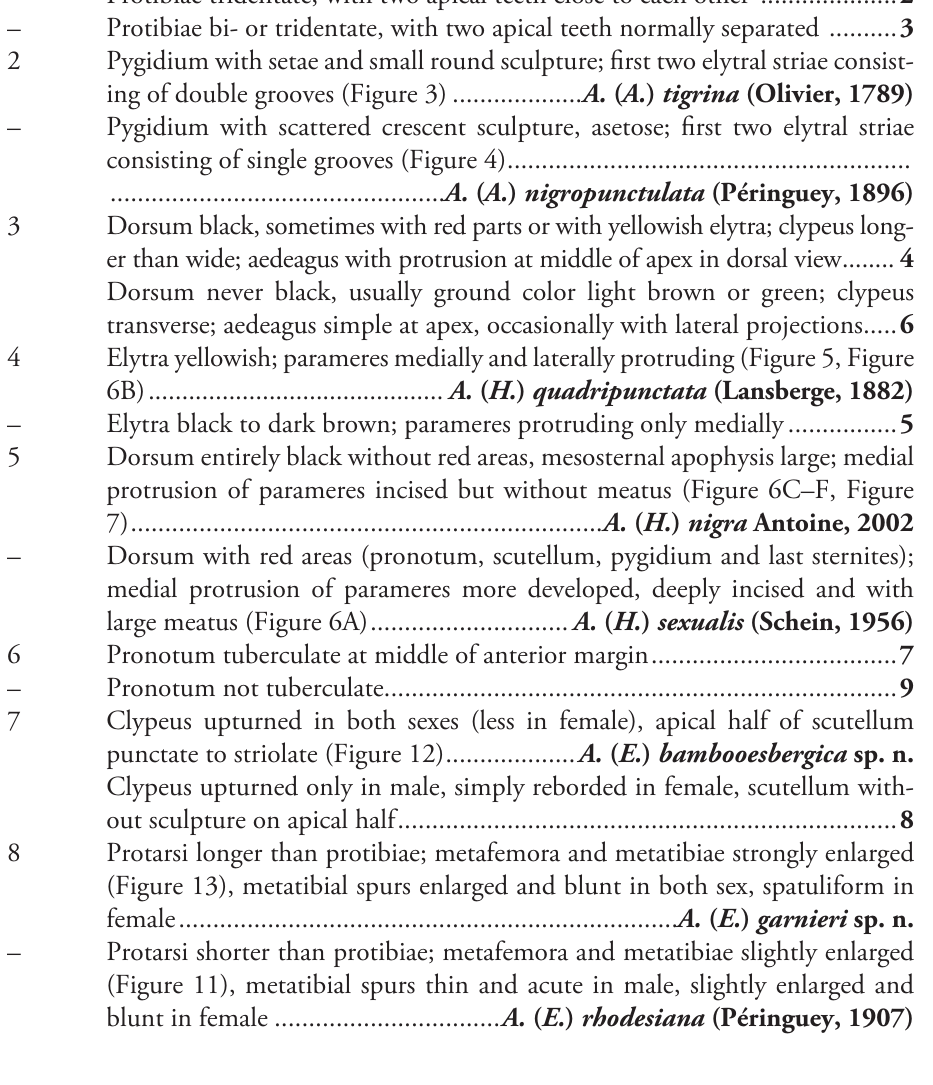
– Protibiae bi- or tridentate, with two apical teeth normally separated .......... 3 2 Pygidium with setae and small round sculpture; first two elytral striae consist- ing of double grooves (Figure 3) ................... A. ( A. ) tigrina (Olivier, 1789) – Pygidium with scattered crescent sculpture, asetose; first two elytral striae consisting of single grooves (Figure 4) ........................................................... ................................................. A. ( A. ) nigropunctulata (Péringuey, 1896) 3 Dorsum black, sometimes with red parts or with yellowish elytra; clypeus long- er than wide; aedeagus with protrusion at middle of apex in dorsal view ........ 4 Dorsum never black, usually ground color light brown or green; clypeus transverse; aedeagus simple at apex, occasionally with lateral projections..... 6 4 Elytra yellowish; parameres medially and laterally protruding (Figure 5, Figure 6B) ............................................ A. ( H. ) quadripunctata (Lansberge, 1882) – Elytra black to dark brown; parameres protruding only medially ................ 5 5 Dorsum entirely black without red areas, mesosternal apophysis large; medial protrusion of parameres incised but without meatus (Figure 6C–F, Figure 7) ..................................................................... A. ( H. ) nigra Antoine, 2002 – Dorsum with red areas (pronotum, scutellum, pygidium and last sternites); medial protrusion of parameres more developed, deeply incised and with large meatus (Figure 6A) ............................. A. ( H. ) sexualis (Schein, 1956) 6 Pronotum tuberculate at middle of anterior margin .................................... 7 – Pronotum not tuberculate........................................................................... 9 7 Clypeus upturned in both sexes (less in female), apical half of scutellum punctate to striolate (Figure 12) ................... A. ( E. ) bambooesbergica sp. n. Clypeus upturned only in male, simply reborded in female, scutellum with- out sculpture on apical half ......................................................................... 8 8 Protarsi longer than protibiae; metafemora and metatibiae strongly enlarged (Figure 13), metatibial spurs enlarged and blunt in both sex, spatuliform in female ......................................................................... A. ( E. ) garnieri sp. n. – Protarsi shorter than protibiae; metafemora and metatibiae slightly enlarged (Figure 11), metatibial spurs thin and acute in male, slightly enlarged and blunt in female ................................. A. ( E. ) rhodesiana (Péringuey,